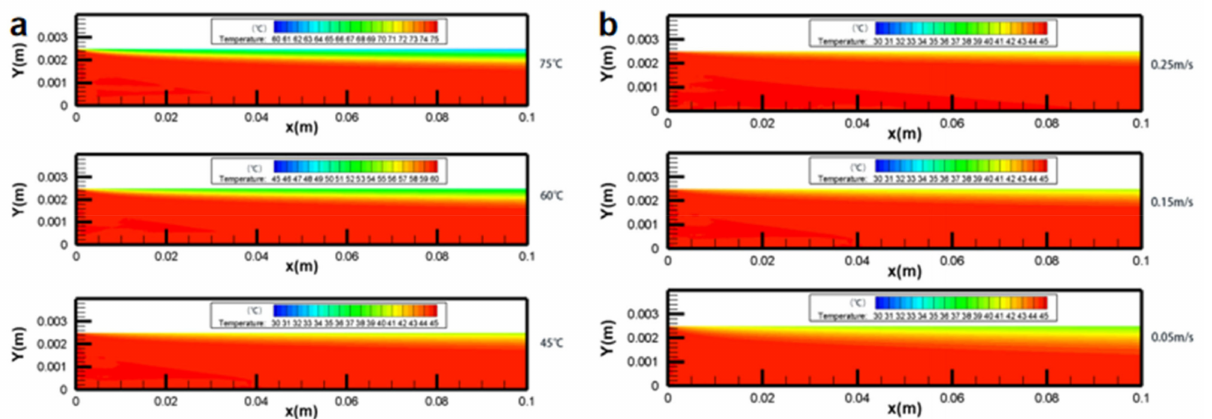
Figure 4. Contours of temperature distribution [15]. Reproduced with permission from MDPI, 2020. ( a ) in different T feed (v feed , v permeate = 0.15 m/s, T permeate = 25 ◦ C, cf = 24.2 wt.%); ( b ) in different vfeed, vpermeate (T feed = 45 ◦ C, T permeate = 25 ◦ C, c feed = 24.2